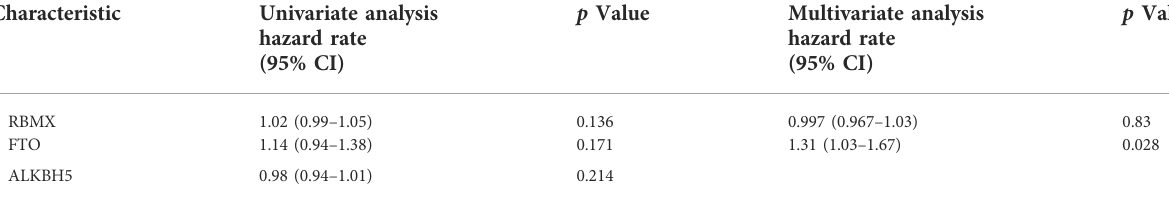
TABLE 2 ( Continued ) Univariate and multivariate analyses of training